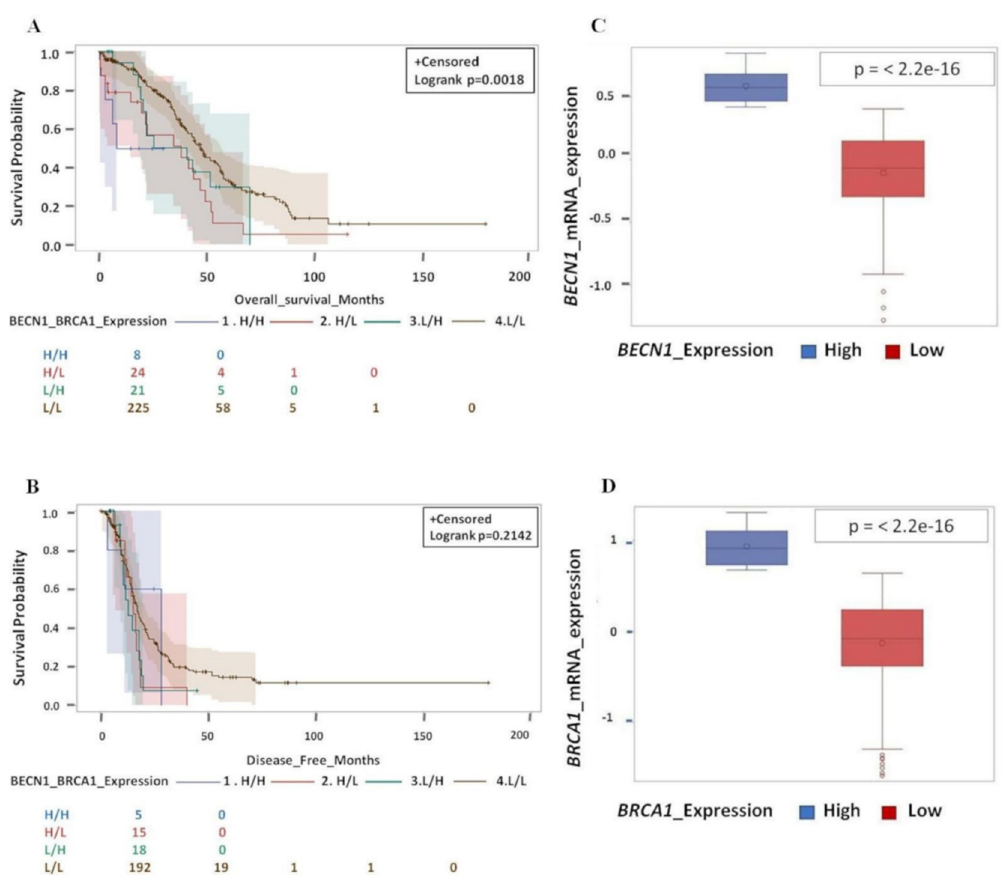
Figure 7. Low expression of both BECN1 and BRCA1 in conjugation gives better and longer overall survival as well as disease-free survival. ( A ) Overall survival for HGSOC patients according to BECN1 and BRCA1 expression level (H/H, H/L, L/H and L/L). ( B ) Disease-free survival for HGSOC patients according to BECN1 and BRCA1 expression level (H/H, H/L, L/H and L/L). ( C ) Box-plot showing the distribution of BECN1 according to expression level (high and low). ( D ) Box-plot showing the distribution of BRCA1 according to expression level (high and low). (Note that for OS data were not available for 1 patient (L/L group 1 pt: 225 pt’s; L/L group total n = 226 pt’s) while for DFS data were missing for 49 patients (H/H group 3 pt’s: 5 + H/L group 10 pt’s: 15 pt’s + L/H group 6 pt’s: 18 pt’s + L/L group 34 pt’s: 192; total n = 279 pt’s),